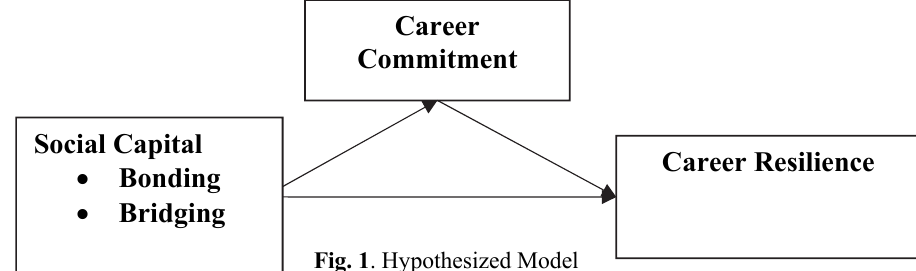
Fig. 1 . Hypothesized